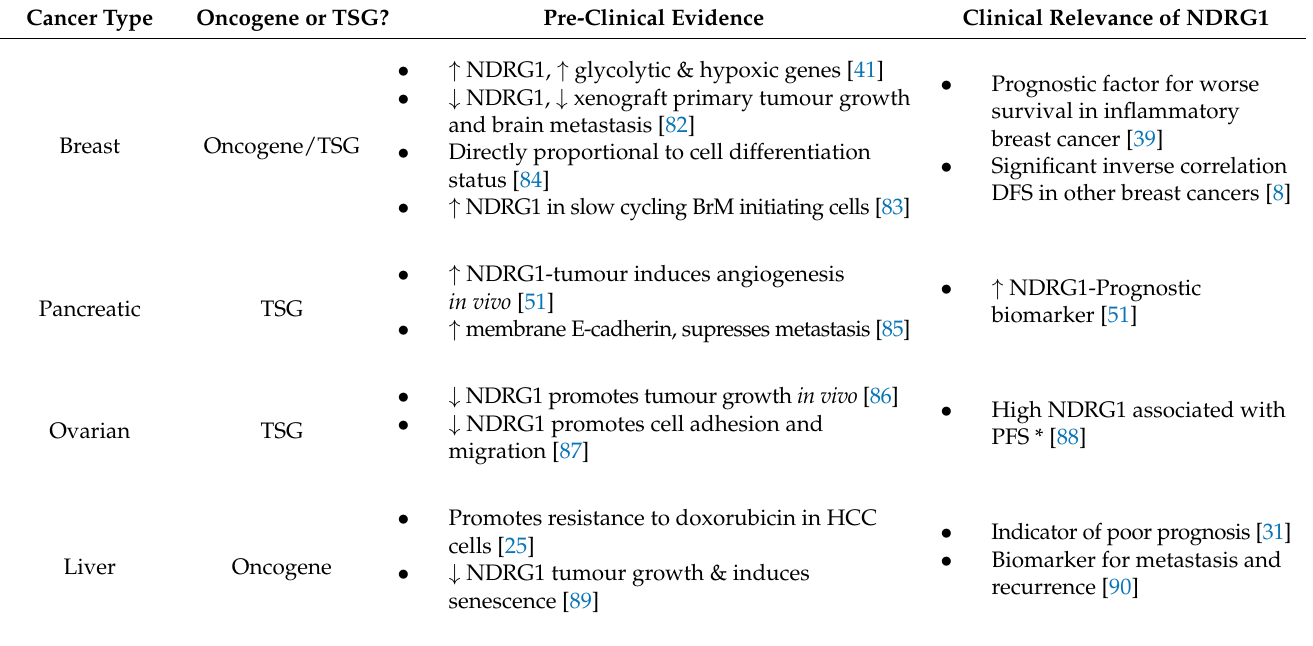
Table 1. Clinical consequences of NDRG1 expression in